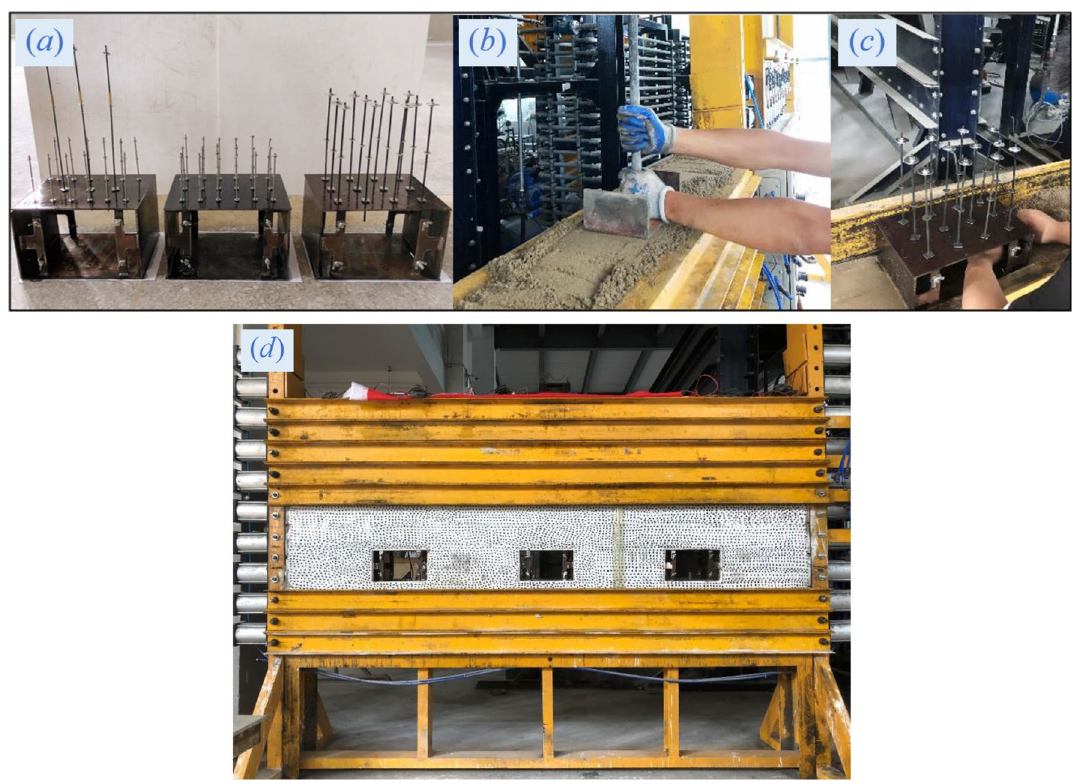
Figure 12. Main steps of model